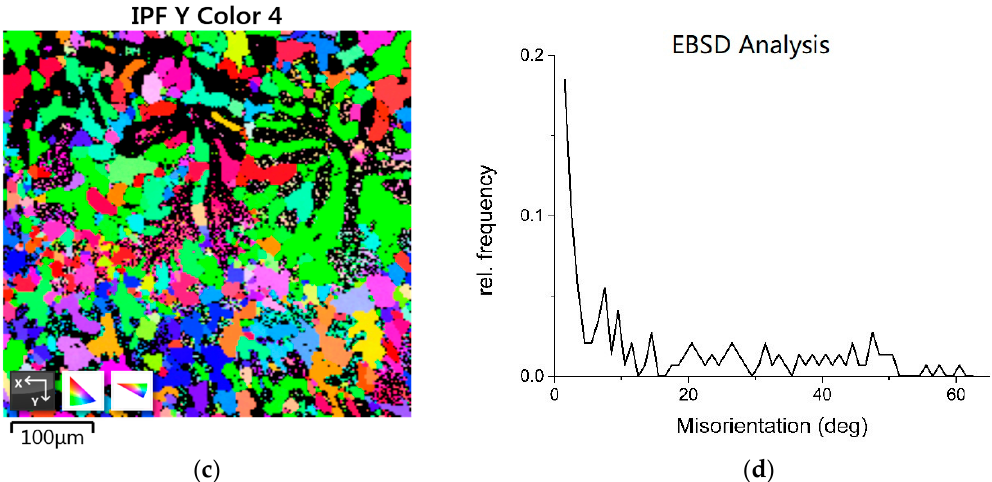
Figure 4. EBSD analyses of the grains with different misorientation grain boundary angles; ( a ) and ( b ) for HC sample; ( c ) and ( d ) for SO sample.